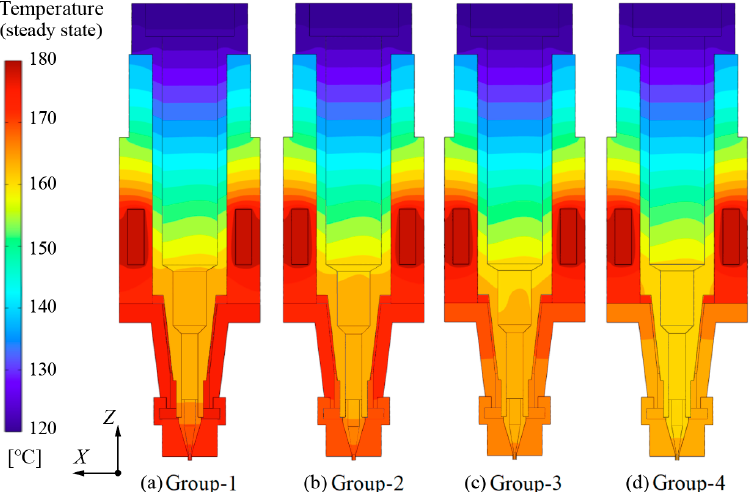
Figure 5. Temperature distribution of the print head in various groups.